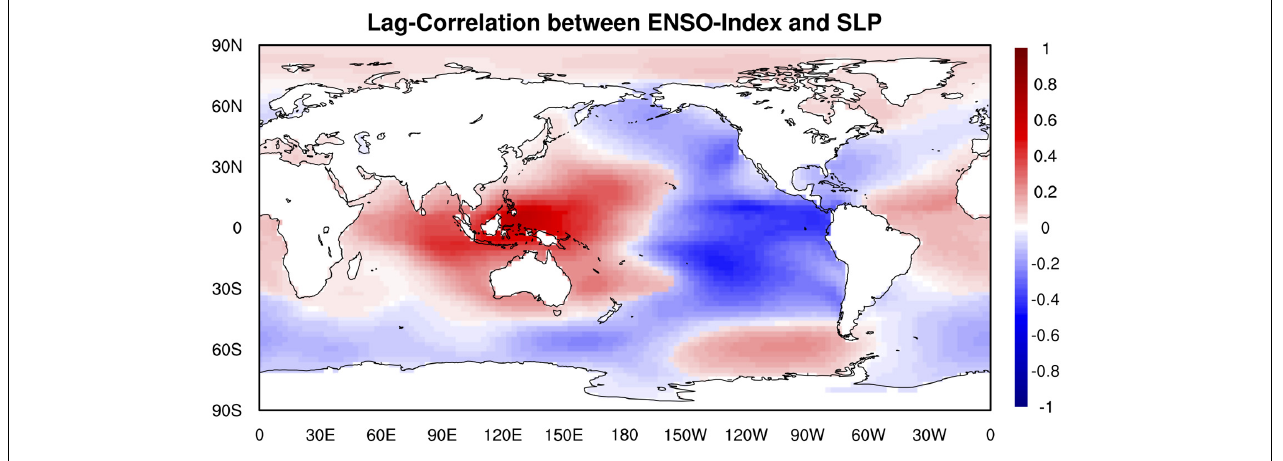
FIGURE 7 | Maximum lag correlation between ENSO index and sea level